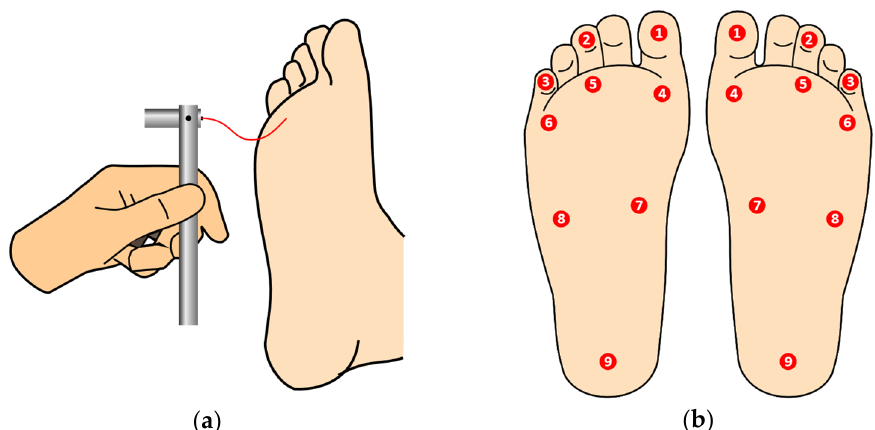
Figure 1. Brief graphical description of the SWME. On the left, ( a ) the application of the monofilament on the plantar area until it starts to buckle, and on the right, ( b ) the plantar testing sites according to international guidelines, on the left and right feet.